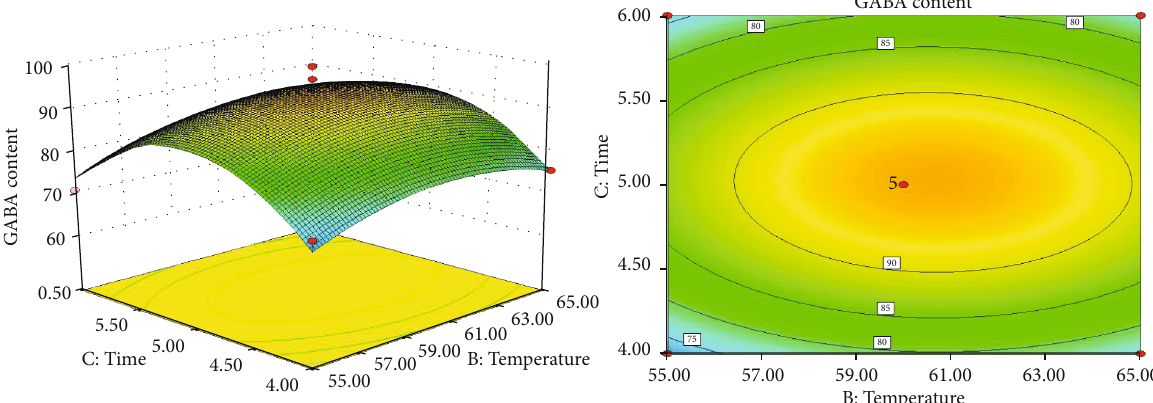
Figure 9: Response surface and contour diagram of time and temperature in fl uence on GABA content.